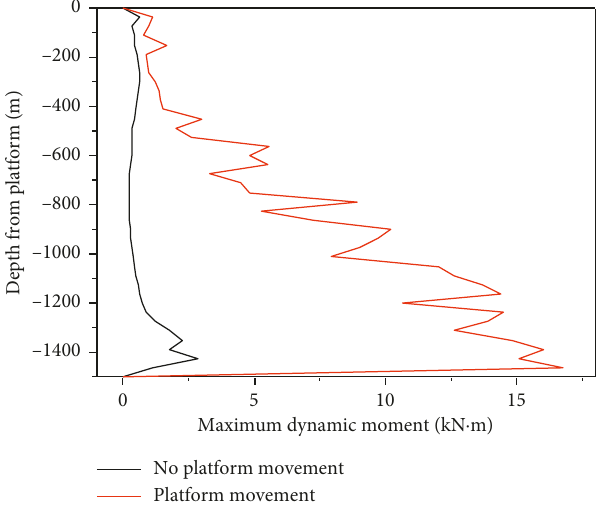
Figure 19: Effect of platform motion on maximum dynamic moment.